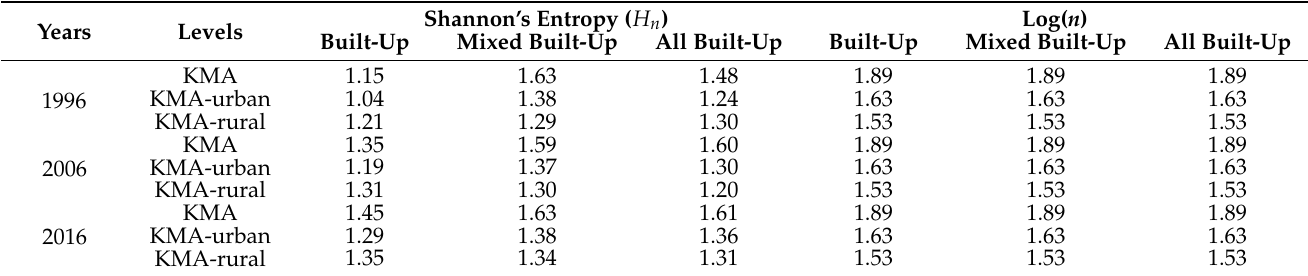
Table 3. Results of H n analysis and the corresponding Log( n ) values for built-up and mixed built-up classes over KMA, KMA-urban, and KMA-rural in 1996, 2006, and 2016. Shannon’s Entropy ( H n Years Levels